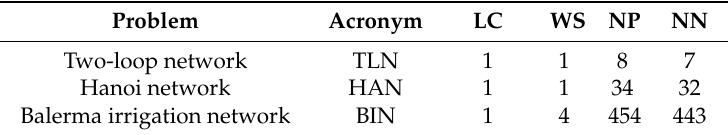
Table 2. Networks characteristics.